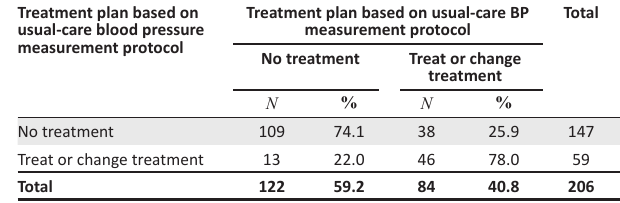
TABLE 4: Comparison of treatment decisions based on usual-care and guideline-concordant blood pressure measurement